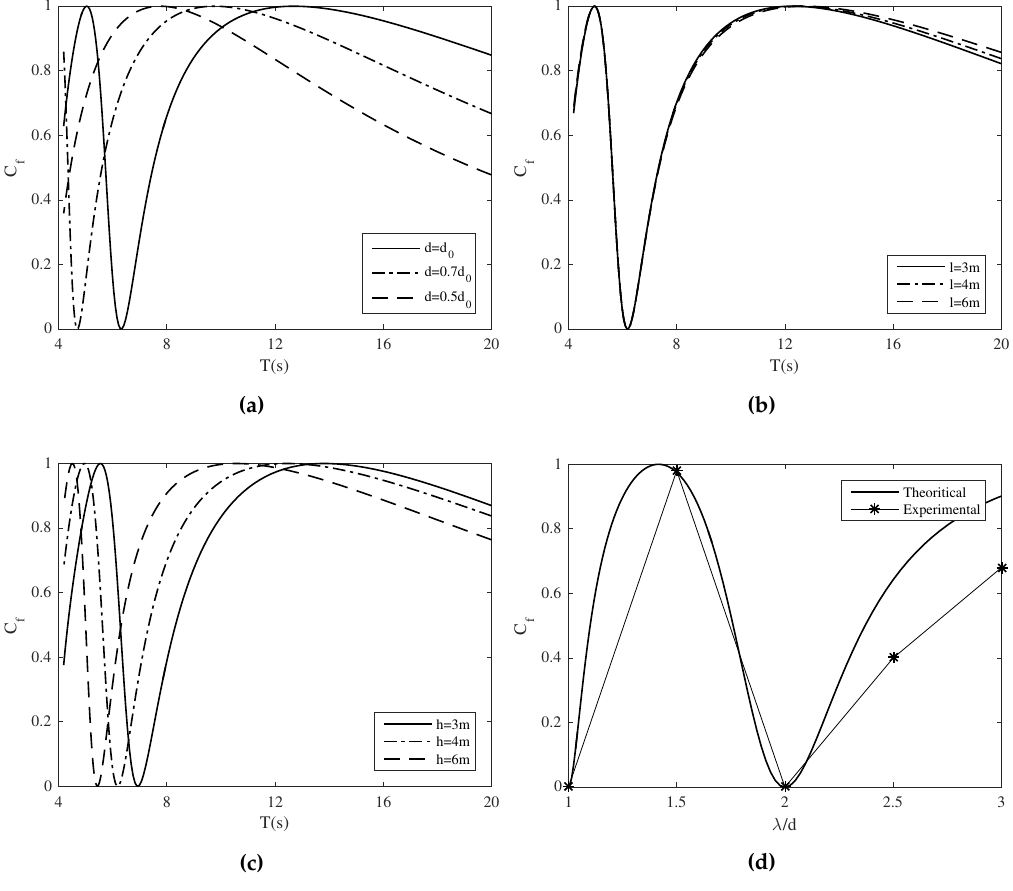
Figure 10. Variation of capture factor ( C f ) with wave period ( T ), for variable ( a ) d , ( b ) l , ( c ) h , and ( d ) experimental [31] and theoretical comparison of C f with normalized wave length ( λ / d ).